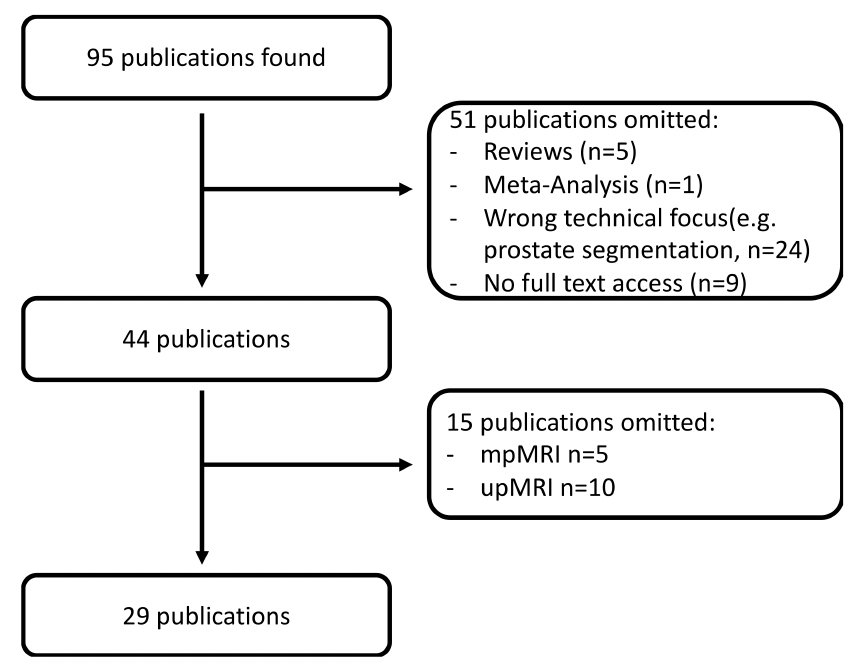
Figure 5. Literature selection work-flow. ML–machine-learning. DL–deep learning. up–uniarametric. bp–biparametric.